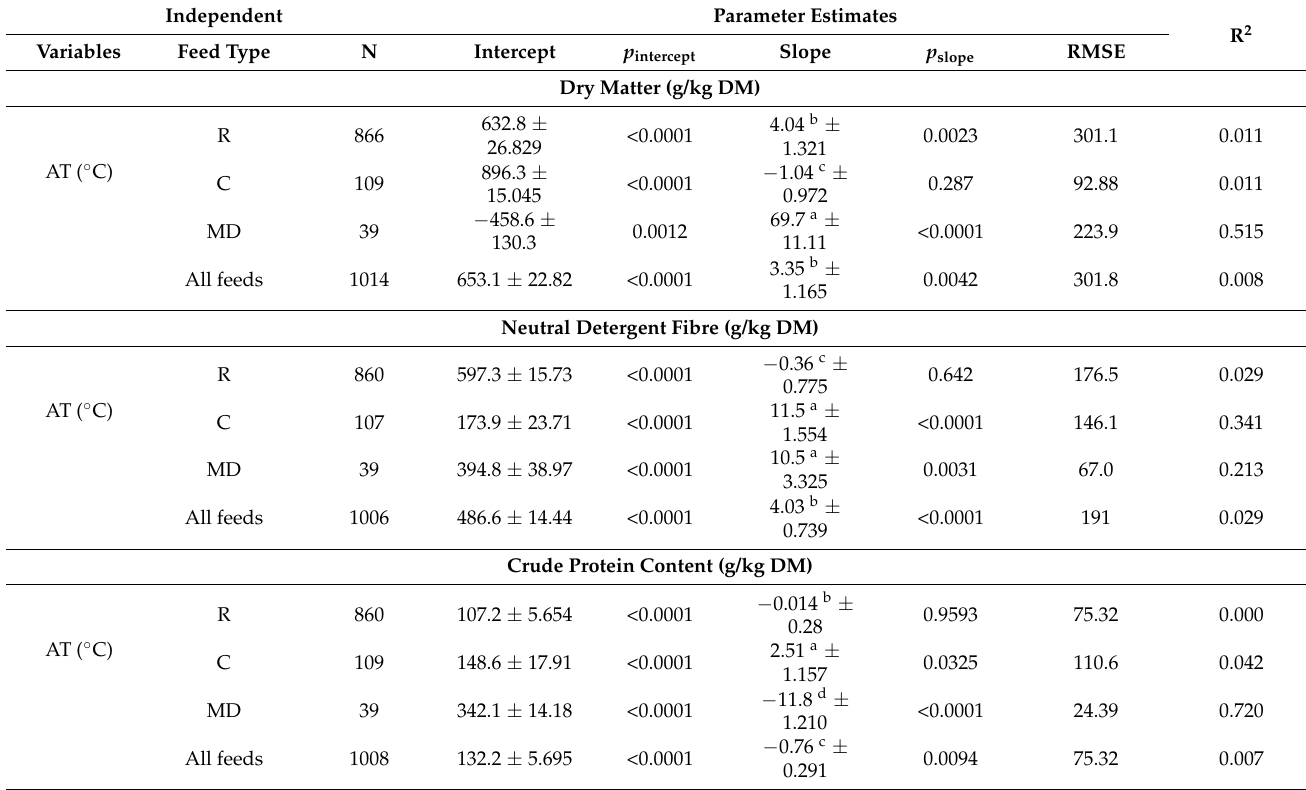
Table 6. Equations for linear regression between chemical composition of feeds degraded in the rumen and ambient